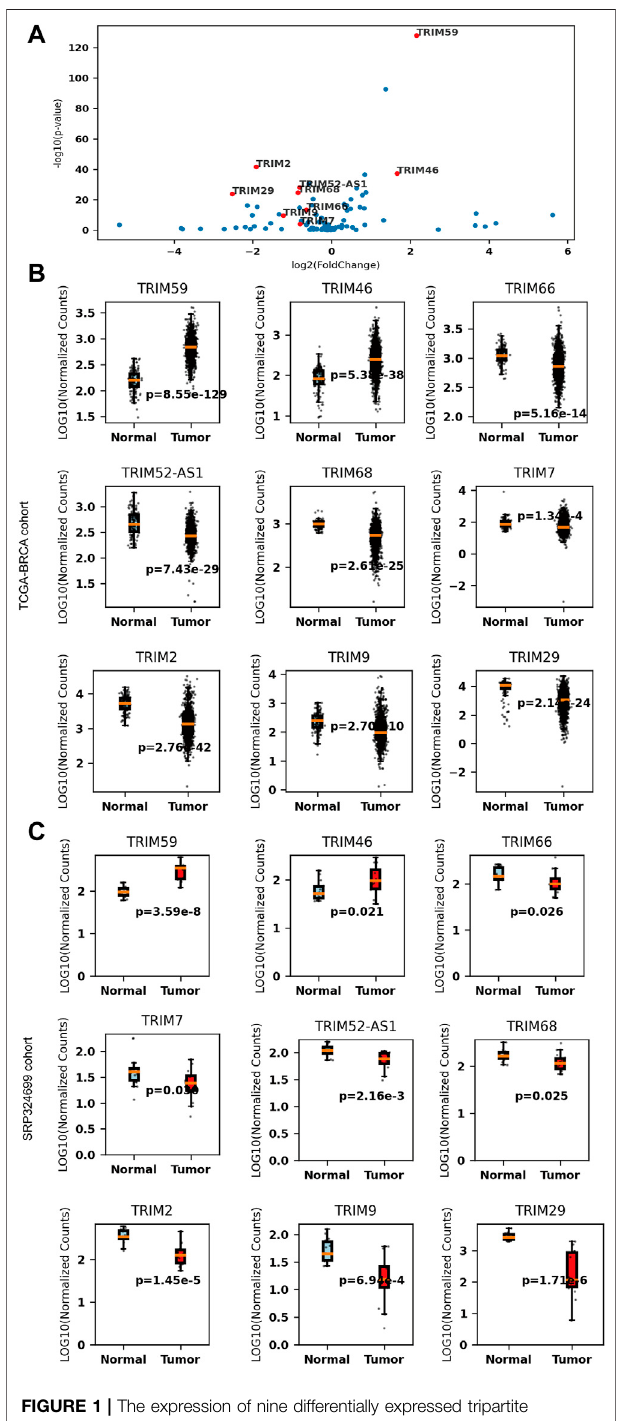
FIGURE 1 | The expression of nine differentially expressed tripartite motif-containing genes (TRIMs) in breast cancer (BC). (A) volcano plot of TRIMs in The Cancer Genome Atlas (TCGA)-BRCA cohort (B) boxplots of the expressionsofupregulated TRIM59 / 46 anddownregulated TRIM66/52- AS1/68/7/2/9/29 in the TCGA-BRCA cohort (N Normal = 112, N tumor = 1075). (C) boxplots of the expressions of upregulated TRIM59 / 46 and downregulated TRIM66/52-AS1/68/7/2/9/29 in the SRP324699 cohort (N Normal = 14, N tumor =